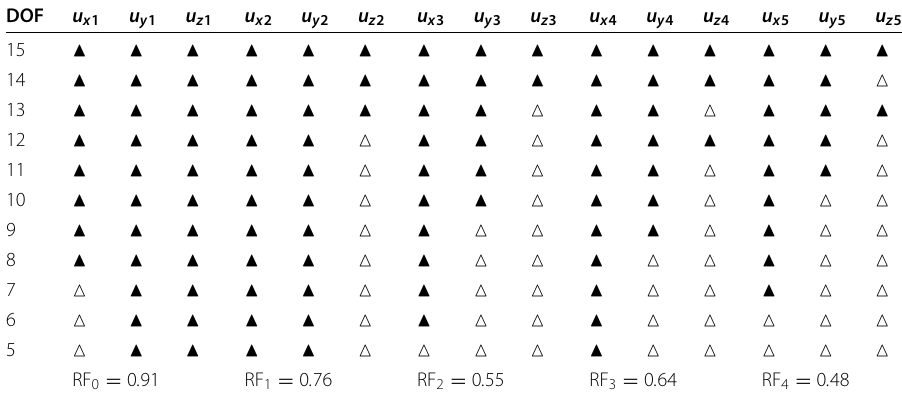
Table14 BTD models for 0/90/0/90, R/a = 5 , a/h = 10 , clamped-free